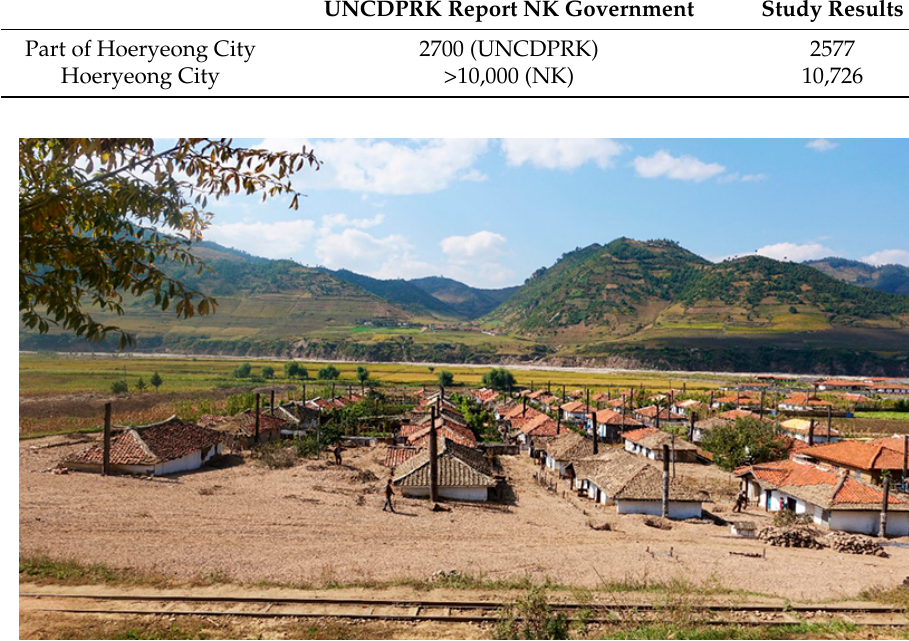
Table 6. Comparison of damaged buildings in the study area.